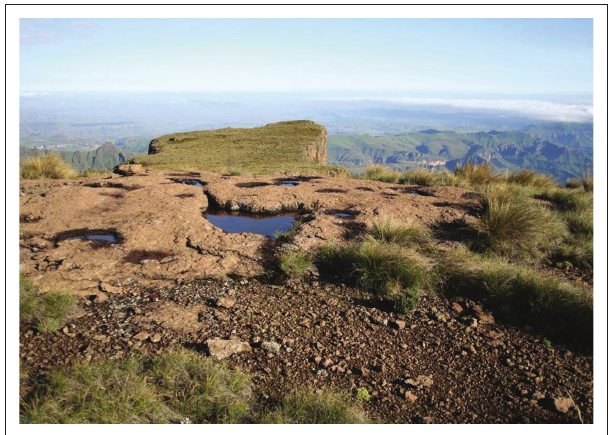
FIGURE 3: Uncommon vernal pools on Cathkin and Outer Buttress, habitat for specialist aquatic plants Aponogeton junceus , Crassula dependens , Crassula gemmifera , Limosella grandiflora and Limosella vesiculosa .